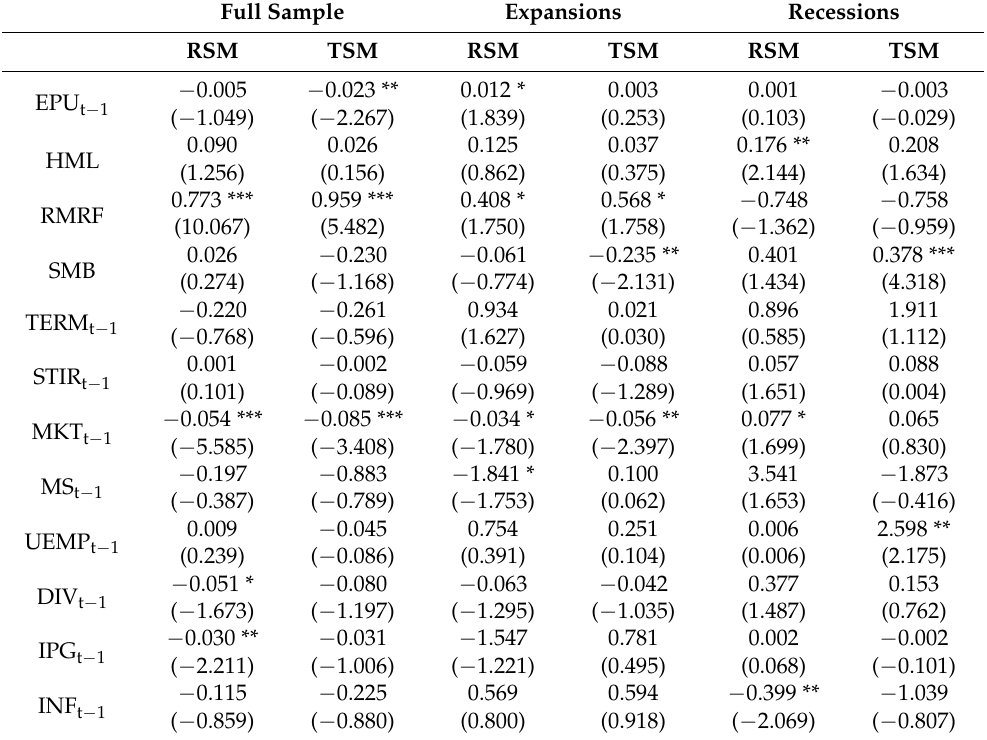
Table 9. Effect of EPU on momentum returns in the Chinese stock market. Note. The left panel shows the full sample results while the medium and right panels indicate the EPU–momentum relationship in the Chinese stock market during expansion and recession periods, respectively. *** denotes significant at 0.01 level, ** denotes 0.05 significance level, and * represents significant at 0.1 level,